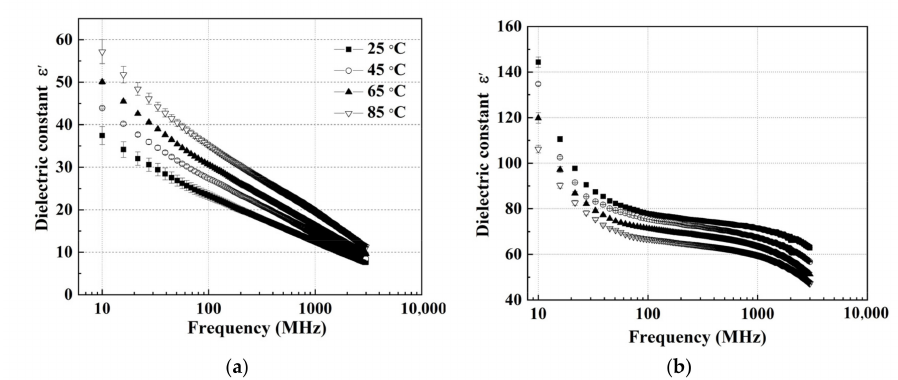
Figure 2. Frequency-dependent dielectric constant ( ε (cid:48) ) of wolfberries with a moisture content of 15.2% ( a ) and 75.1% (w.b.) ( b ).